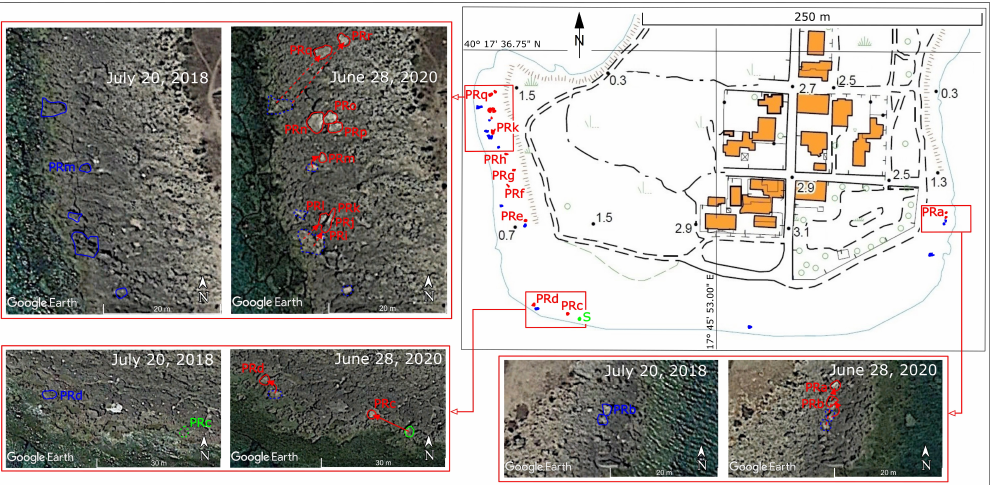
Figure 3. Comparative satellite images of Punta Prosciutto. The initial positions of the boulders are highlighted in blue, the final ones in red, and sockets are green. Red arrows highlight the displacements. Topography from the technical map of Lecce Province